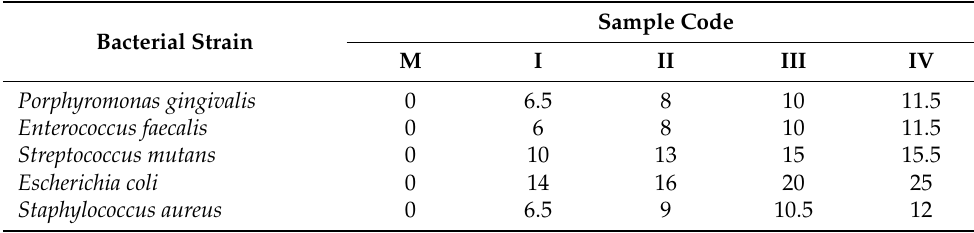
Table 5. Diameters of inhibition zones (mm) for tested hydrogel samples.